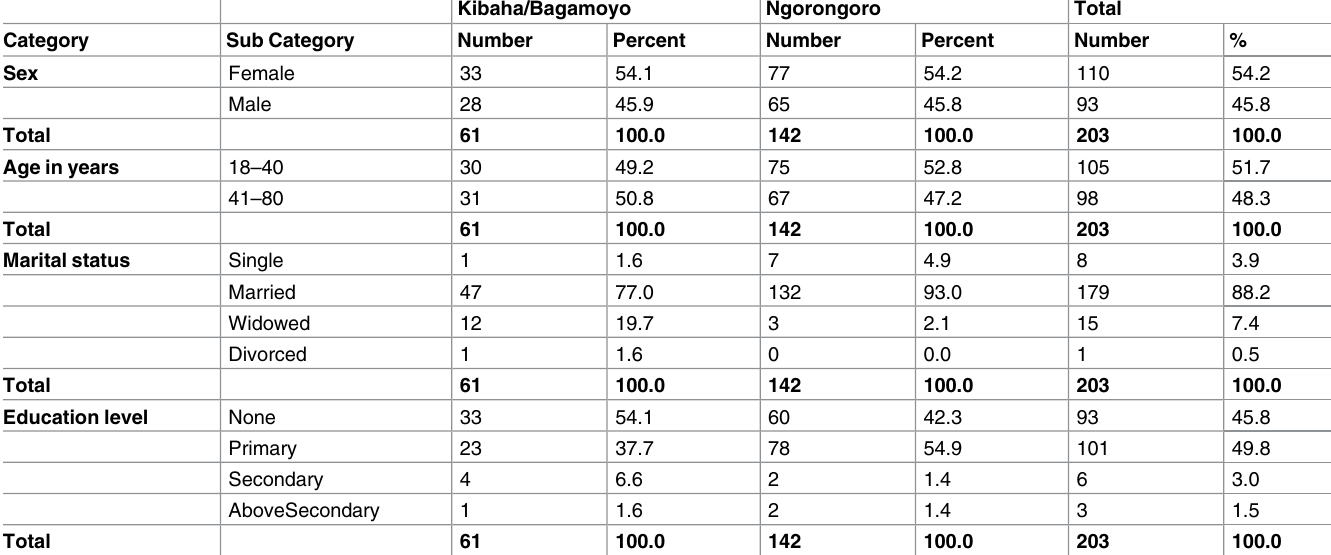
Table 2. Socio-demographic characteristics of the FGD participants.